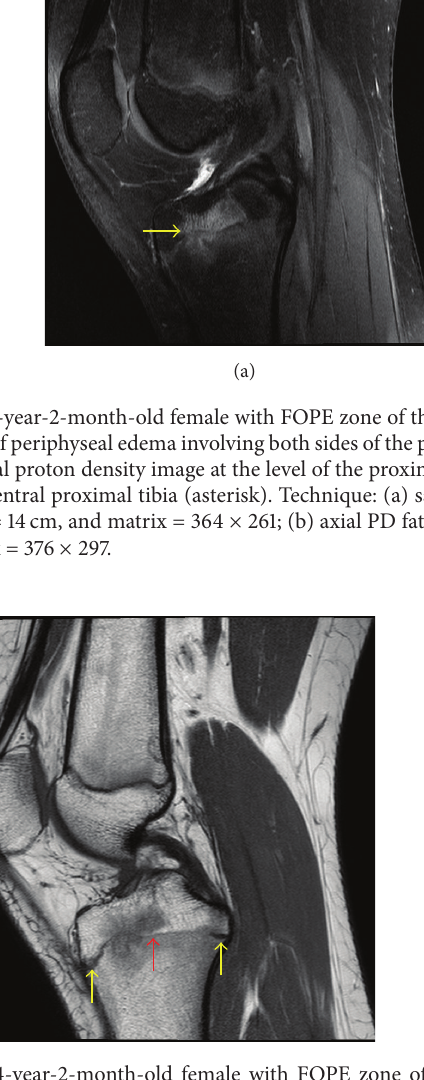
Figure 9: A 14-year-2-month-old female with FOPE zone of the proximal tibia. Findings: Sagittal T1 weighted image shows partial closure of the proximal tibia physis centrally (red arrow) with the physis still open along the periphery of the tibia (yellow arrows). The distal femur physis is narrowed but still open by comparison. Low T1 signal intensity corresponding to the periphyseal edema is again seen spanning the proximal tibia physis. Technique: sagittal T1 MRI (TR = 621.991, TE = 15), ST = 3 mm, spacing = 3.3 mm, FOV = 14cm, and matrix = 340 × 277.